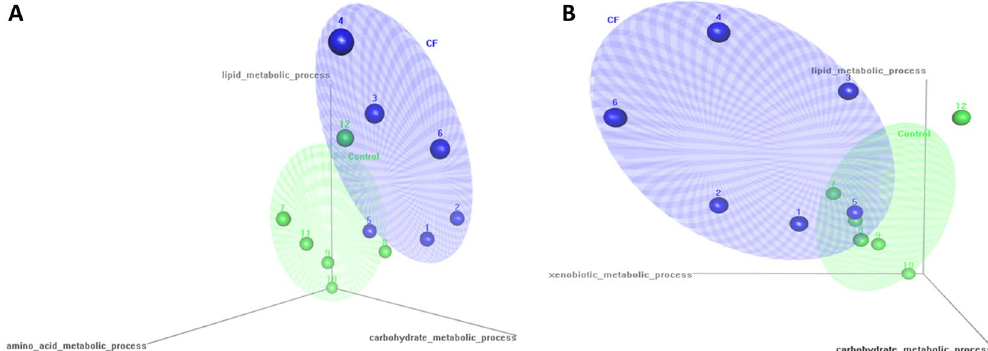
x-axis = GO:0005975|BP|03| carbohydrate metabolic process, y-axis = GO:0006629|BP|03| lipid metabolic process, z-axis = GO:0006520|BP|03|cellular amino acid metabolic process (Panel A) or xenobiotic metabolism